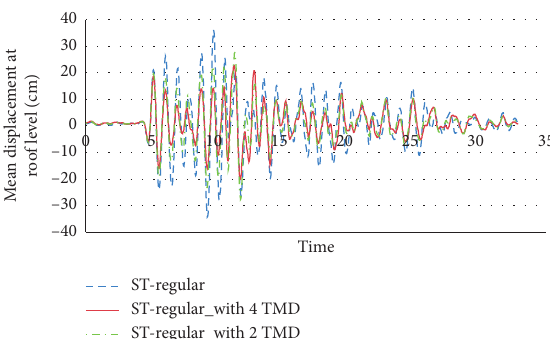
Figure 18: Displacement of the ten-story regular model with 2 and 4 dampers.